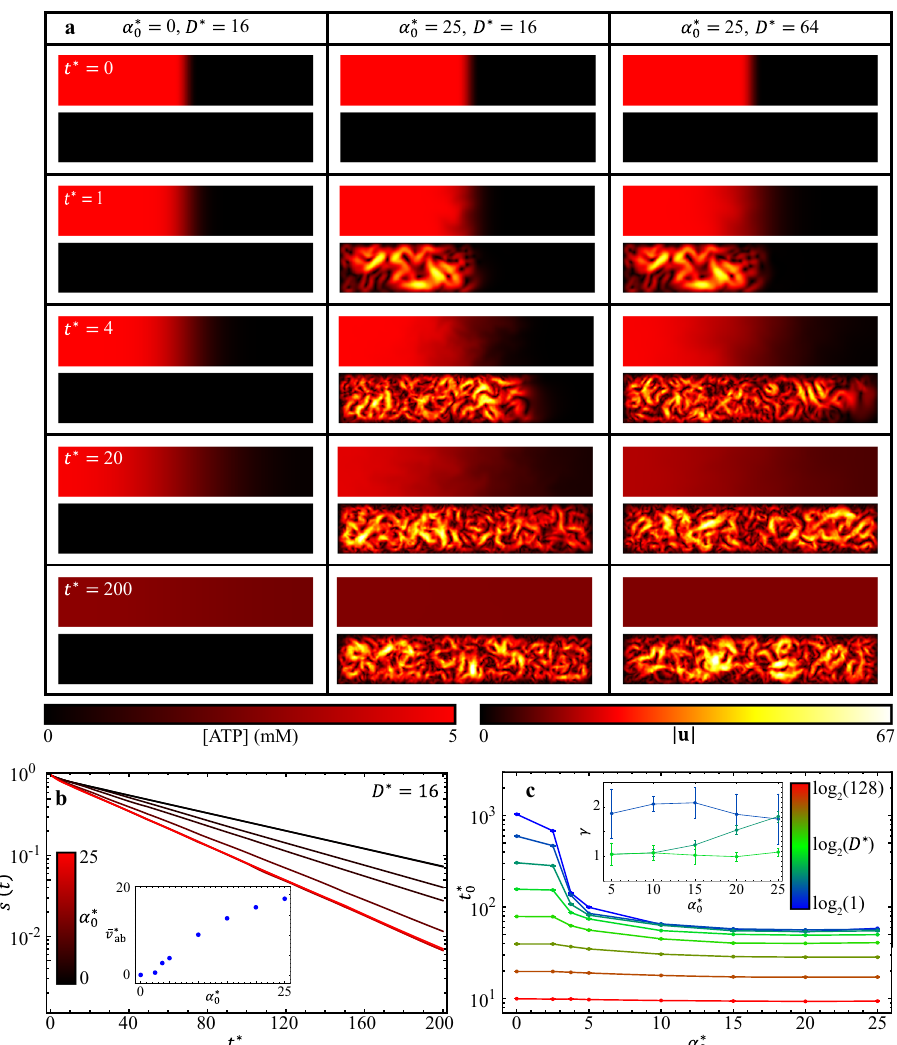
Fig.6 |(Modelingresults)Acontinuousactive fl uidsimulationrevealsthatthe mixing time of ATP depends on the dimensionless molecular diffusion coef fi - cient of ATP and the dimensionless activity level of active fl uid. a Table of ATP concentration (top panels) and active fl uid fl ow speed (bottom panels) maps for various dimensionless activity levels α * 0 and molecular diffusion coef fi cients D * . When the fl uid hasno activity ( α * 0 =0; left column), ATP disperses to the right side of the system only by molecular diffusion; the dispersion is enhanced when the active fl uid starts to fl ow and actively transport ATP ( α * 0 =25; middle column). The dispersionisfurtherenhancedwhenATPdiffusessigni fi cantlyfaster( D * = 64;right column) (Supplementary Movie 4). b Evolution of normalized multiscale norm for α